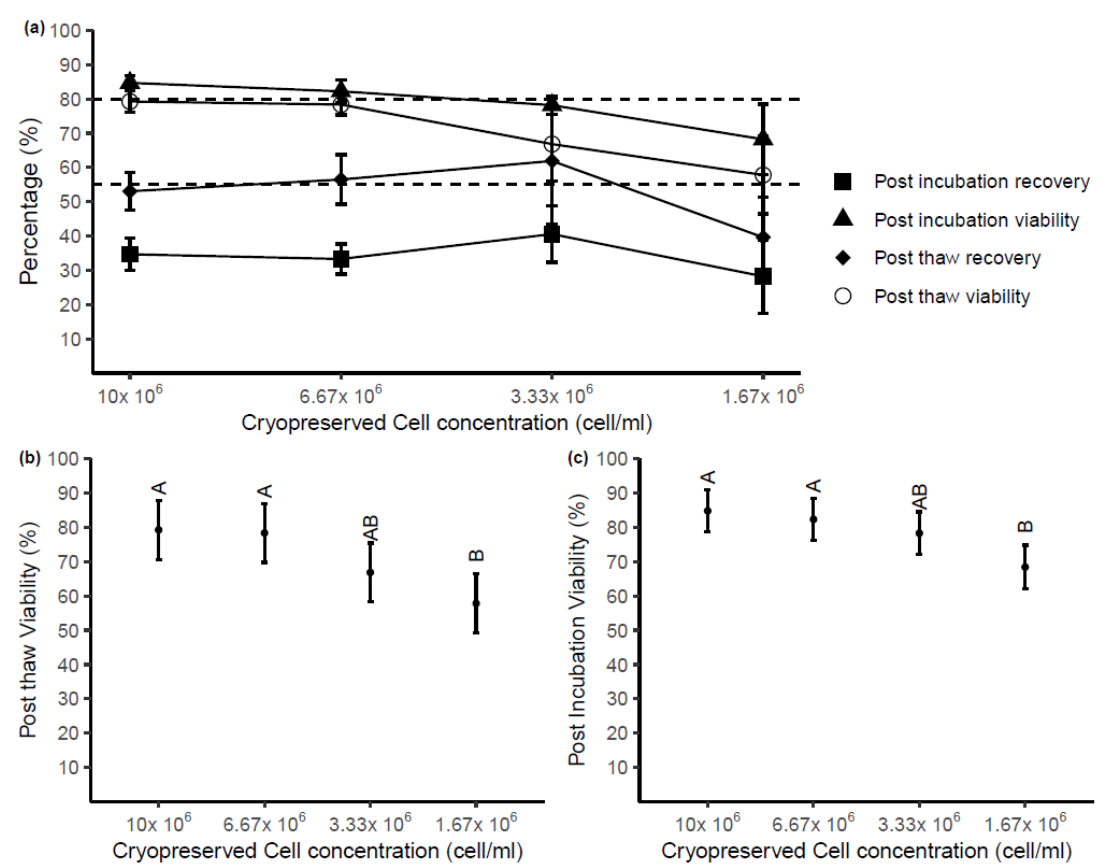
Figure 4. ( a ) Post-thaw and post-incubation viability and recovery from samples stored at decreasing cell concentrations in 150 µL of cryopreservation media. Each point represents the mean of raw data with SD (n = 4). Acceptable criteria: Post- thaw viability ≥80%, post- thaw recovery ≥55% ( b ) The impact of cryopreserved cell concentration on post-thaw viability. Means that are not significantly different in statistical analyses are labeled with the same letter (predicted mean with 95% CI, n = 4). ( c ) The impact of cryopreserved cell concentration on viability and after overnight incubation at 37 C (predicted mean with 95% CI, n = 4). Letters (A, B) indicate groups (Tukey’s test), where predicted means that are not significantly are labeled with the same letter.